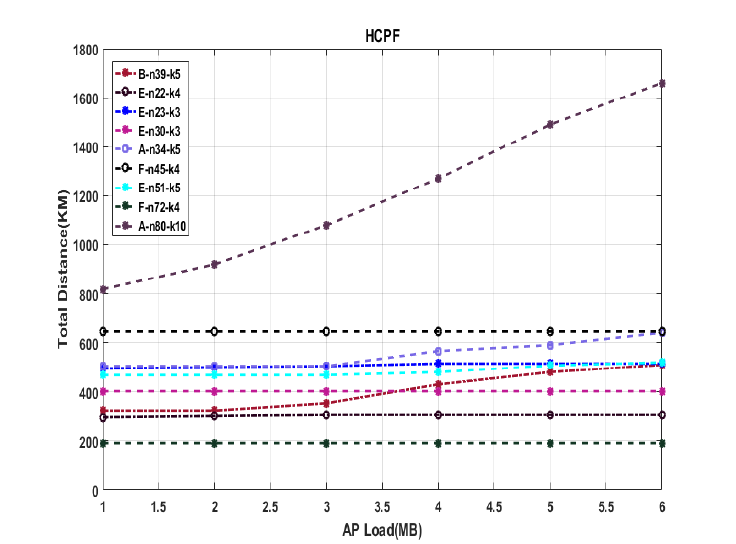
Figure 7. AP load vs. total distance (GA).